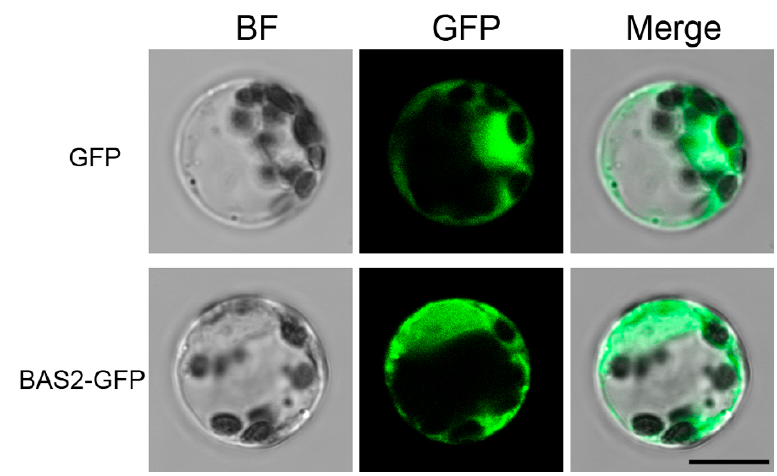
Figure 4. Subcellular localization of BAS2-GFP in mesophyll cell protoplasts of H. brasiliensis . Scale bar = 10 μ m. Scale bar = 10 µ m.